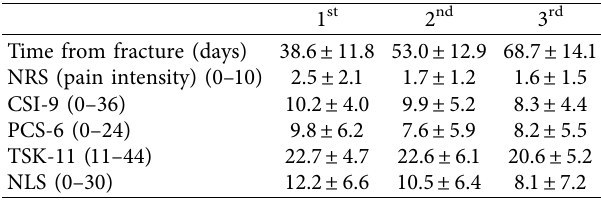
Table 1: Comparison of the time points of each evaluation did not reveal any signifcant